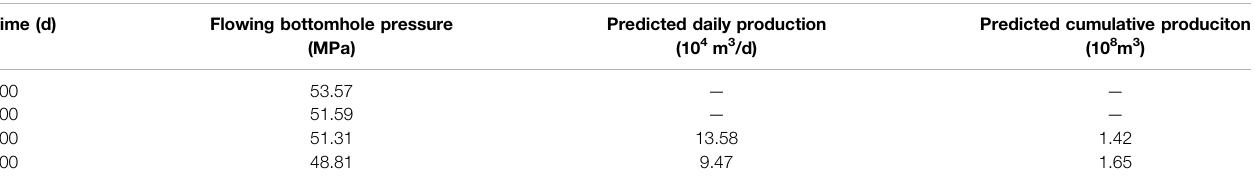
TABLE 3 | Production prediction of Well